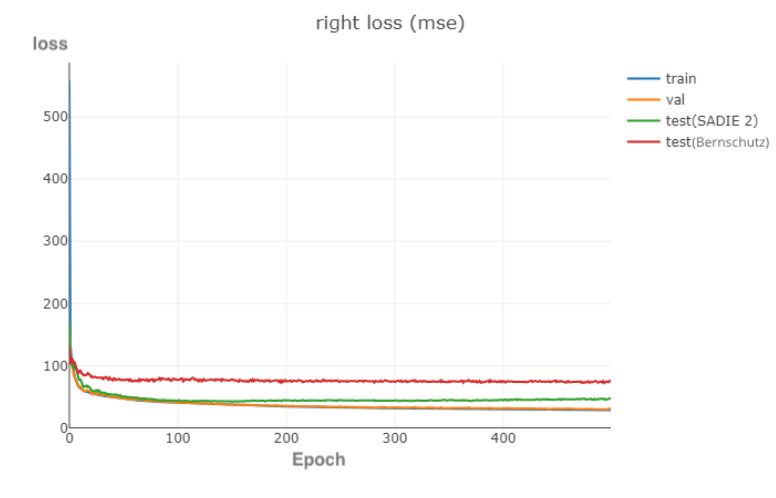
Figure 8. Right MSE during training (blue: training loss, orange: validation loss, green: hold out test data Subject 20 from SADIE II, red: Bernschutz KU100), demonstrating that the model over-fit the training data.